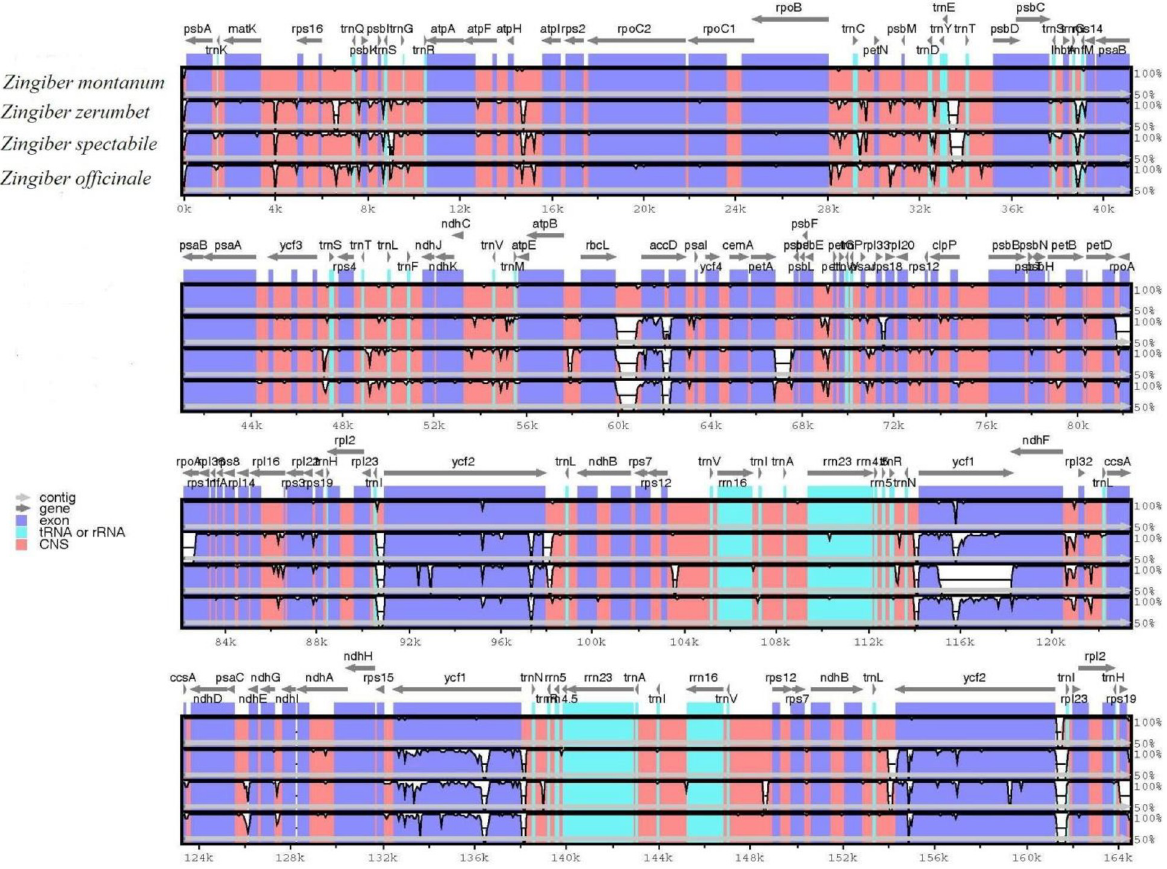
Fig 7. Sequence alignment of the four Zingiber chloroplast genomes in mVISTA. The chloroplast genome of Z . montanum was used as a reference. Gray arrows and thick black lines above the alignment indicate gene orientation. Purple bars represent exons, sky-blue bars represent transfer RNA (tRNA) and ribosomal RNA (rRNA) and red bars represent noncoding sequences (CNS). The horizontal axis indicates the coordinates within the chloroplast genome. The vertical scale represents the identity percentage ranging from 50% to 100%. White represents regions with sequence variation among the four